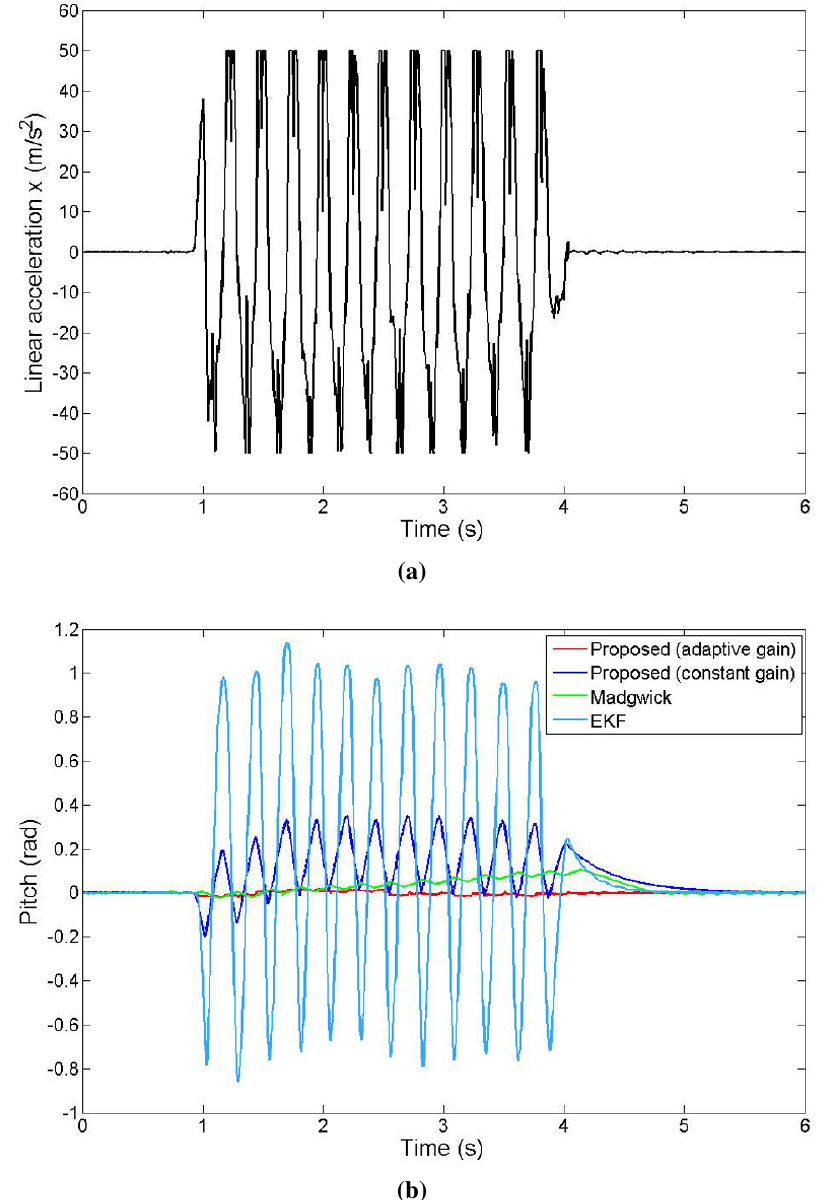
Figure 9. Pitch estimation under the condition of high nongravitational acceleration; ( a ) Non gravitational acceleration applied during the experiment; ( b ) Pitch angle output of the different